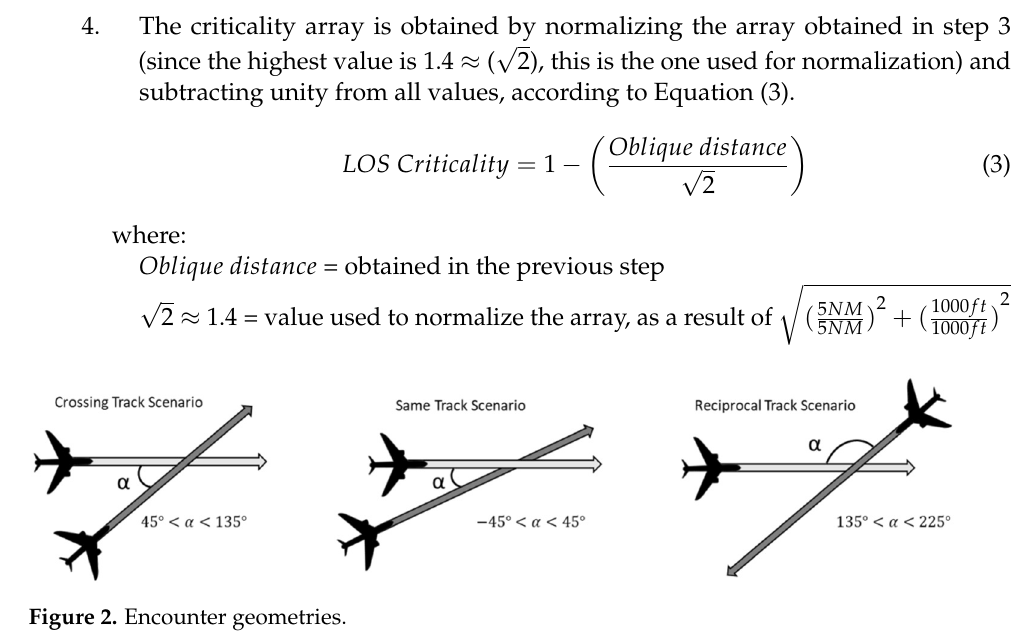
Figure 2 . Encounter geometries. Figure 2. Encounter geometries.